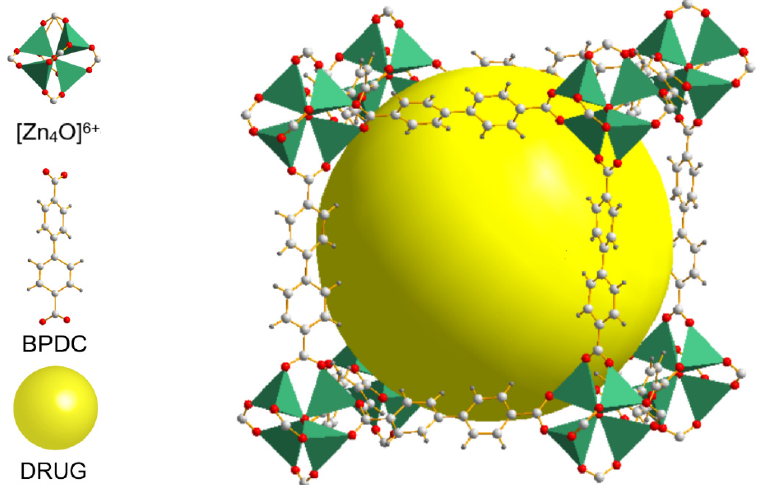
Figure 2. Schematic illustration of the construction of IRMOF-10.